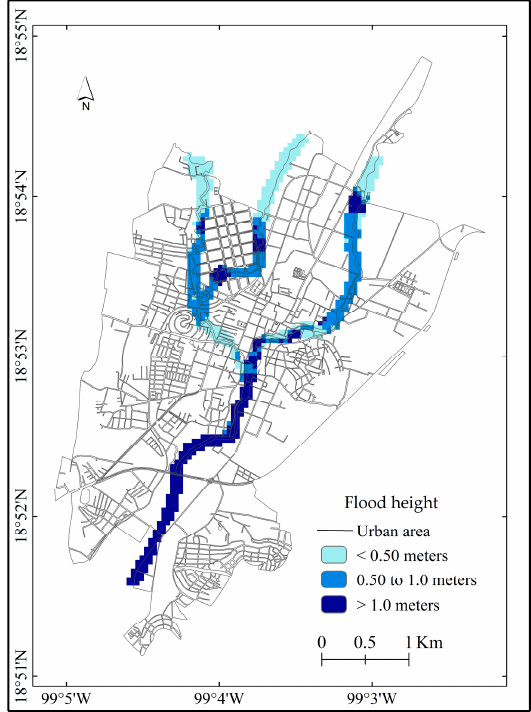
Figure 6. Hydrological hazard map for Rp = 500 years due to overflow of the Yautepec, Oacalco and Apanquetzalco rivers. Table 3. Hydrological hazard levels for different return periods (Rp)*. Flood level (m). Hazard Level.